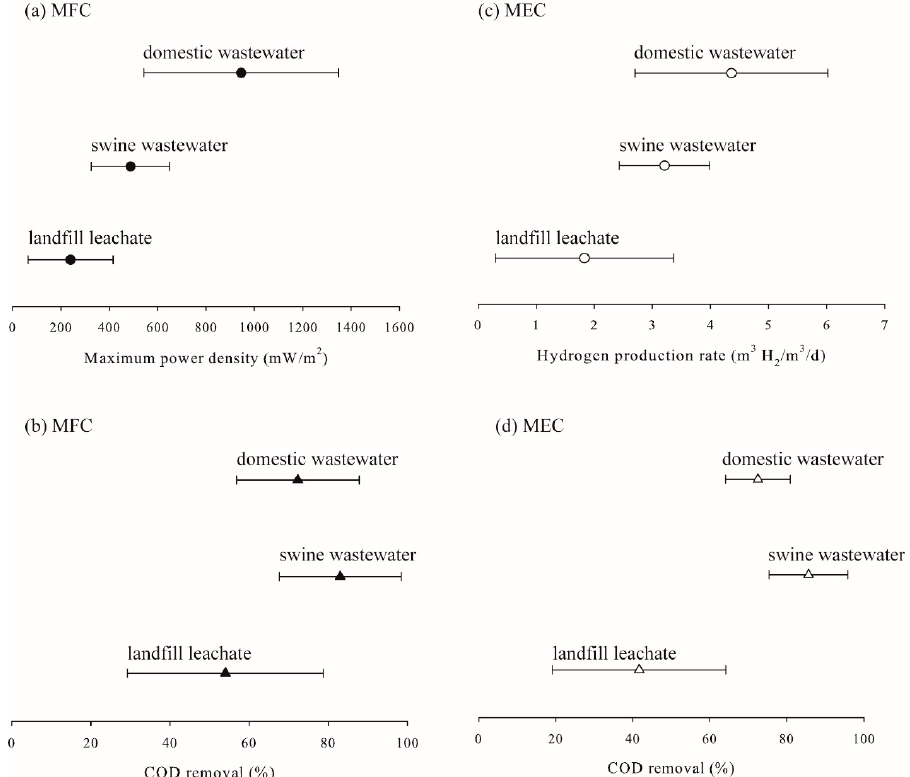
Figure 5. Influences of substrate type on ( a ) an MFCs’ power generation, ( b ) an MFCs’ COD removal, ( c ) an MECs’ hydrogen production, and ( d ) MECs’ COD removal.